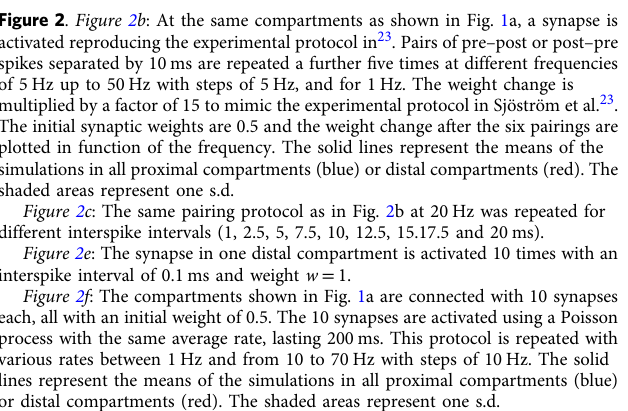
Figure 1b : to all compartments shown in Fig. 1a, a synapse at the weight w max = 1 was connected. For each compartment, the following simulation was performed: the connected synapse was activated 10 times with an interspike interval of 1ms while storing the membrane potential at the soma. This protocol was repeated for interspike intervals of 4 ms and 8ms. Figure 1b shows the mean (solid line) and standard deviation (shaded region) of the somatic potential calculated for all proximal compartments (blue) and distal compartments (red). The AMPA and NMDA components were not plastic and both conductances were 2nS. Figure 1c, d : For each compartment of the basal dendrites in our morphological neuron, a number of synapses with weights fi xed at w = 1.5 were activated with interspike intervals of 1ms and the local membrane voltage was recorded during the subsequent 50ms. The simulation was repeated with an increased number of synapses until a threshold at − 15mV was crossed. By comparing the local voltage with the somatic voltage, it was determined whether this threshold was crossed due to an NMDA spike or a somatic spike. The number of synapses needed to reach this threshold was stored. Figure 2 . Figure 2b : At the same compartments as shown in Fig. 1a, a synapse is activated reproducing the experimental protocol in 23 . Pairs of pre – post or post – pre spikes separated by 10ms are repeated a further fi ve times at different frequencies of 5 Hz up to 50Hz with steps of 5 Hz, and for 1Hz. The weight change is multiplied by a factor of 15 to mimic the experimental protocol in Sjöström et al. 23 . The initial synaptic weights are 0.5 and the weight change after the six pairings are plotted in function of the frequency. The solid lines represent the means of the simulations in all proximal compartments (blue) or distal compartments (red). The shaded areas represent one s.d. Figure 2c : The same pairing protocol as in Fig. 2b at 20 Hz was repeated for different interspike intervals (1, 2.5, 5, 7.5, 10, 12.5, 15.17.5 and 20 ms). Figure 2e : The synapse in one distal compartment is activated 10 times with an interspike interval of 0.1ms and weight w = 1. Figure 2f : The compartments shown in Fig. 1a are connected with 10 synapses each, all with an initial weight of 0.5. The 10 synapses are activated using a Poisson process with the same average rate, lasting 200 ms. This protocol is repeated with various rates between 1 Hz and from 10 to 70 Hz with steps of 10Hz. The solid lines represent the means of the simulations in all proximal compartments (blue) or distal compartments (red). The shaded areas represent one s.d. Figure 3 . We implemented two layer 5 biophysical neurons (using the same morphology) for all simulations. All synaptic weights are initiated at 0.5, the maximal AMPA conductance and the NMDA conductance were equal to 1nS. A potentiated synapse was de fi ned as a synapse that had a larger weight value at the end of the simulation compared to the initial value. Bidirectionally connected neurons were de fi ned as neurons where the mean of synaptic weights to both neurons was larger at the end of the simulation compared to the start. Uni- directionally connected neurons were de fi ned as neurons where only the mean of the synaptic weights to one neuron was larger at the end compared to the start, while the mean of the weights to the other neuron was smaller at the end compared to the start. Unconnected neurons were de fi ned as neurons where the mean to both neurons was smaller compared to the initial value. We realise that looking at the mean value of the weights to discriminate between unidirectional and bidirectional is not completely accurate (one can imagine strengthening of some weights and weakening of others in some situations), but it gives us an adequate way of comparing the synaptic weight changes for the different protocols. Action potentials in the neurons were evoked by injecting a brief current into the soma, with an instantaneous rise of 15 nA and an exponential decay back to zero with a time constant of 0.1ms. Figure 3a – d : Each neuron made 15 synaptic connections onto its partner. The synaptic locations were drawn randomly across the whole-basal tree. In both neurons, spikes were induced following a Poisson point process with a fi xed average rate, and the neurons were simulated for 5 s. We then repeated the simulation for all combinations of rates between 0 and 20 Hz, with 2 Hz steps, and stored all the fi nal synaptic weights for every case. We then repeated the whole protocol 20 times with different randomly drawn synaptic locations, which we also stored. (b) For each of the 15 simulated pairs of neurons, we calculated the mean synaptic distance from the soma and the amount of potentiated synapses present across all combinations of fi ring rates. (c, d) Two examples of simulation outcomes for different randomly chosen synaptic locations. See above for our de fi nition of unidirectional and bidirectional connections. Figure 3e – h : Each neuron made 10 synaptic connections on its partner. The synaptic locations were drawn randomly across either the proximal or distal compartments as shown in Fig. 1a. In both neurons, spikes were induced following a Poisson point process with a fi xed average rate, and we simulated the neurons for 5s. We then repeated the simulation for all combinations of rates between 0 and 20Hz, with 2Hz steps, and stored all the fi nal synaptic weights for every case. We